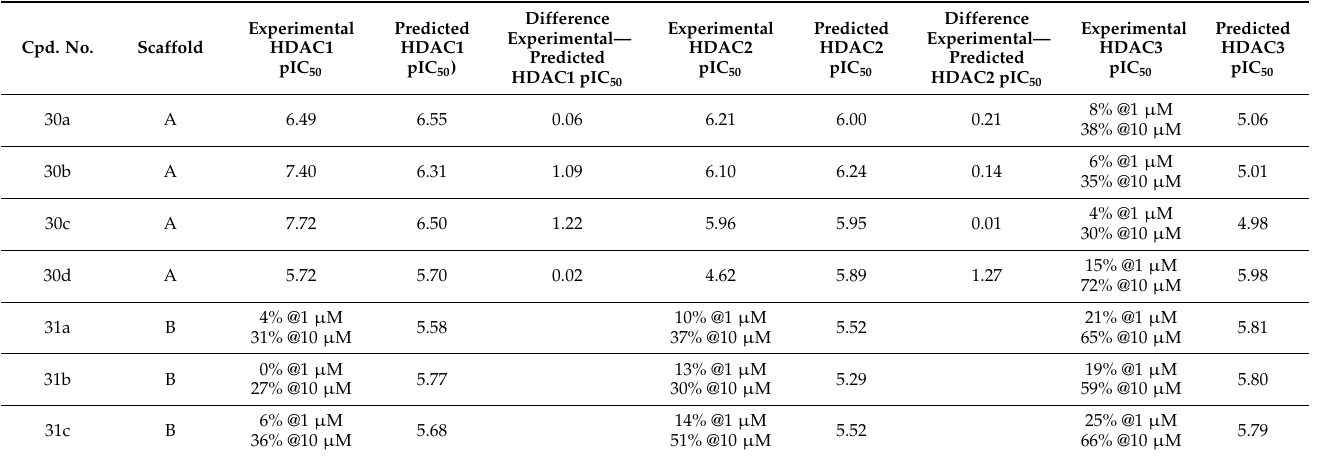
Table 4. Experimental and predicted activities (pIC 50 or inhibition percent at a given concentration) of the test set compounds against